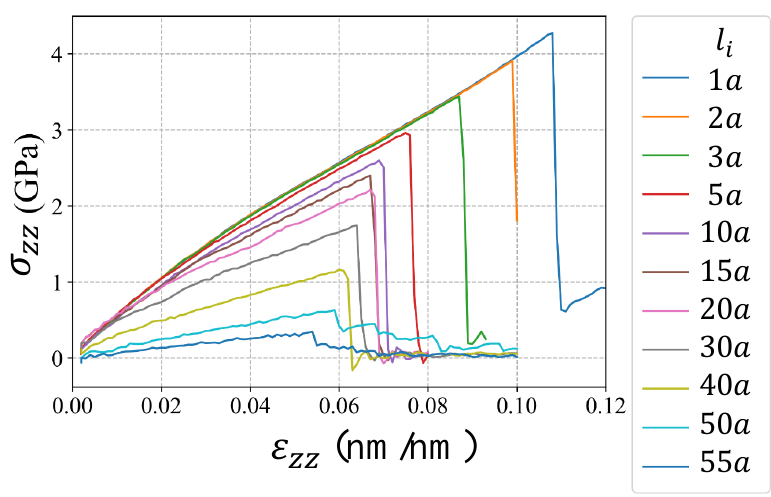
Figure 2. Atomistic system for ( a ) bi-crystal and ( b ) single-crystal Al.